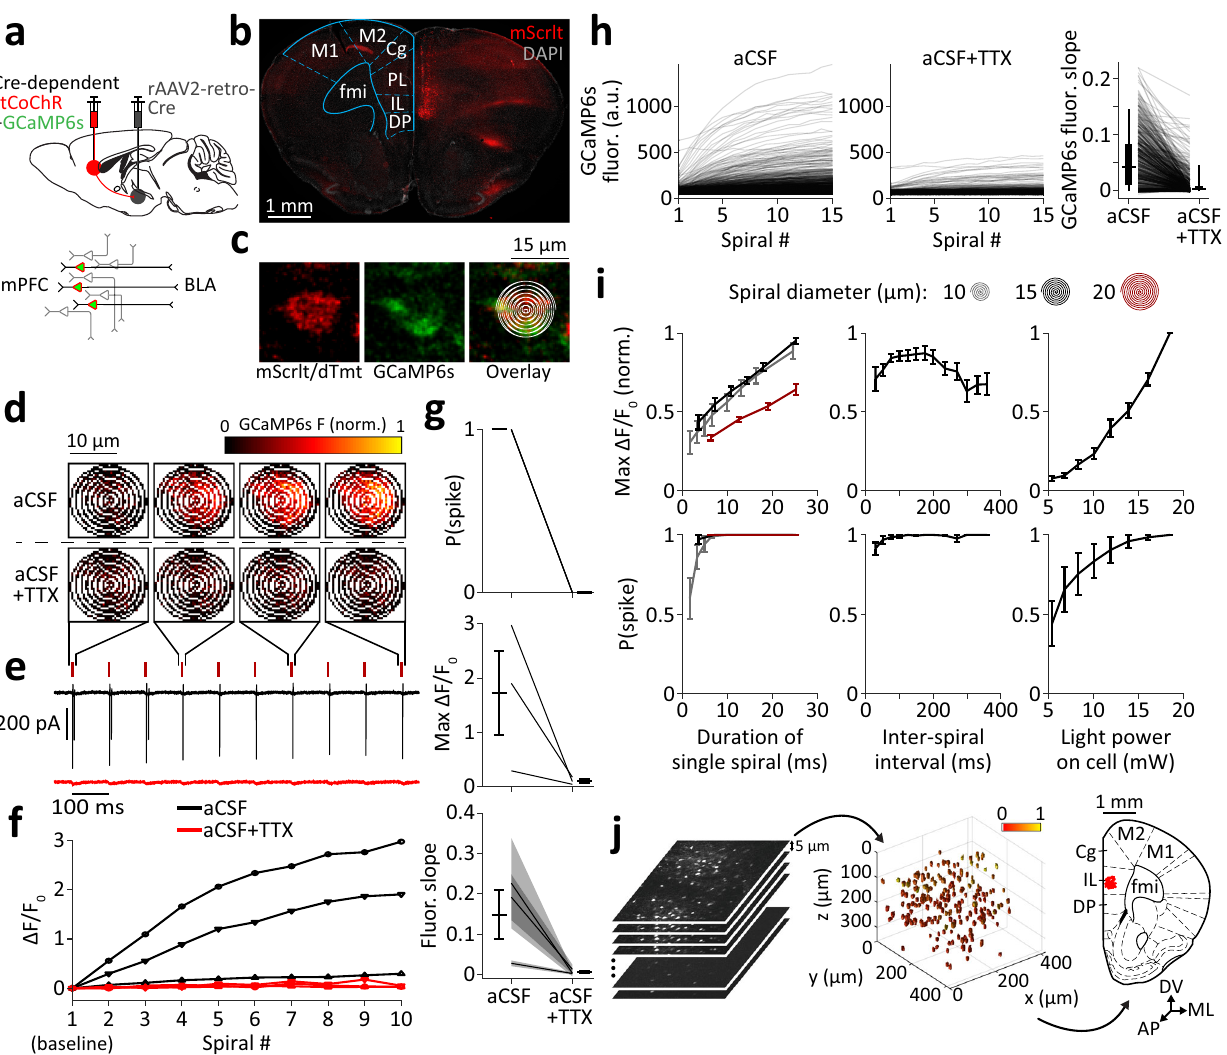
Fig. 1 | Simultaneous optogenetic stimulation and GCaMP6s-based spike readout using a single laser source. a Top, Intersectional viral strategy for expressing stCoChR (co-expressed with mScarlet) and GCaMP6s (co-expressed with nuclear dTomato) in mPFC cells projecting to the BLA (mPFC-BLA cells). Sagittalatlasillustrationwasadaptedfromref. 107 .Bottom,Schematicofexpression ofstCoChRandGCaMP6sexclusivelyinmPFC-BLAcells. b Representativeconfocal imageofacoronalsectionshowingexpressionofstCoChRandGCaMP6sinmPFC- BLA cells. Anatomical region outline is adapted from ref. 54 . c Representative two- photon images of a cell targeted for spiral scanning, with the spiral-scan pattern overlaid (right). d , e Cell-attached recordings from an mPFC-BLA cell expressing stCoChRandGCaMP6s.Trainsof10spiralpatterns(7.1mseach)werescannedat10 Hz over the soma as in c to excite stCoChR and GCaMP6s, and GCaMP6s fl uores- cence was recorded during the scan of each spiral. d Raw GCaMP6s fl uorescence (normalized to the maximum) during four selected spirals in absence of TTX (top, aCSF) and after application of TTX to block spiking (bottom, aCSF+TTX). e Cell- attached recording traces from the same cell shown in d , in absence (black) and presence (red) of TTX. Red ticks denote spiral-scan times. f , g Cell-attached recordings from three mPFC-BLA cells during spiral scanning asin d , e . f GCaMP6s Δ F/F 0 without TTX (black) and with TTX (red) over 10 spirals for each cell. Plotted symbolsindicateindividualcells. g Probabilityforatleastonespikeperspiral(top), maximal GCaMP6s Δ F/F 0 (middle), and slope of the linear fi t of the raw GCaMP6s fl uorescencetrace(bottom),withandwithoutTTX.Hereandelsewhere,errorbars indicate mean ± SEM, unless indicated otherwise. Lines represent individual cells, andshadedregionsinthe fl uorescenceslope(bottom)indicatethe95%con fi dence interval of the slope for each cell. h Raw GCaMP6s fl uorescence of automatically